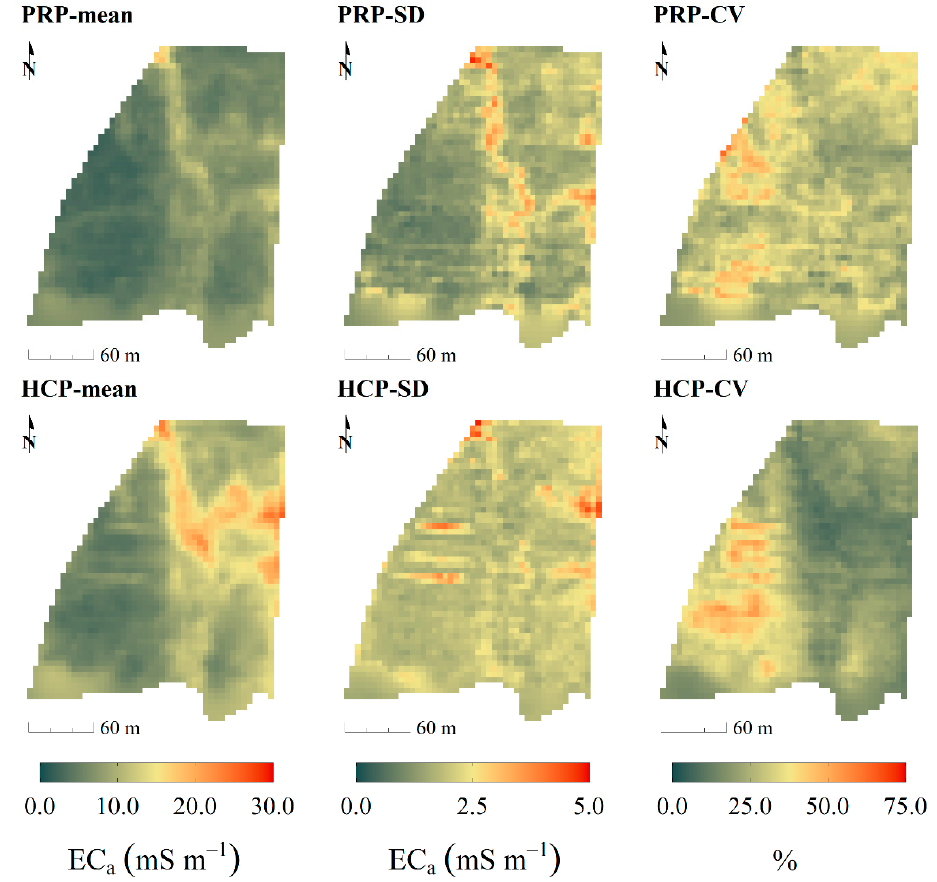
Figure 5. The overall mean, standard deviation (SD), and coefficient of variation (CV) for all 12 universally kriged, perpendicular (PRP) and horizontal coplanar geometry (HCP) apparent electrical conductivity (EC a ) surveys conducted between 2020 and 2021 at the agroforestry site in Fayetteville, AR. Maps were created in R Studio (version 4.05, R Core Team, Boston, MA, USA).